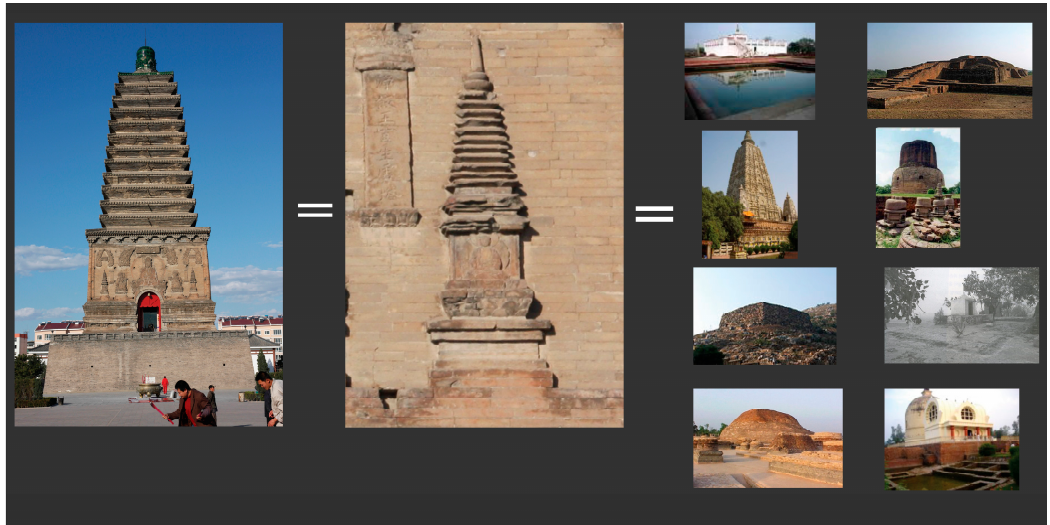
Figure 14. Diagram created by Youn-mi Kim©.